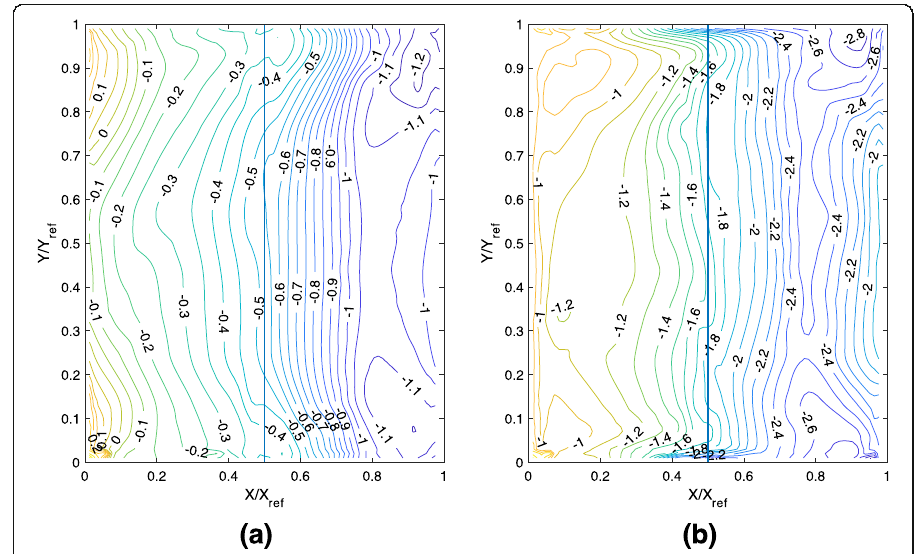
Fig. 19 Contours of roof pressure coefficients ( θ = 90 deg.), for the 6 ft. parapet case: ( a ) mean Cps, and ( b ) 95% quantile peak